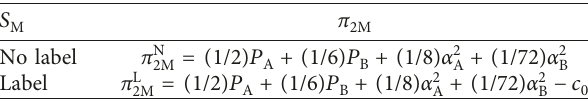
Figure 6: Income ranges of supplier M in AIGM. Table 3: Optimal amount of advertising investment.